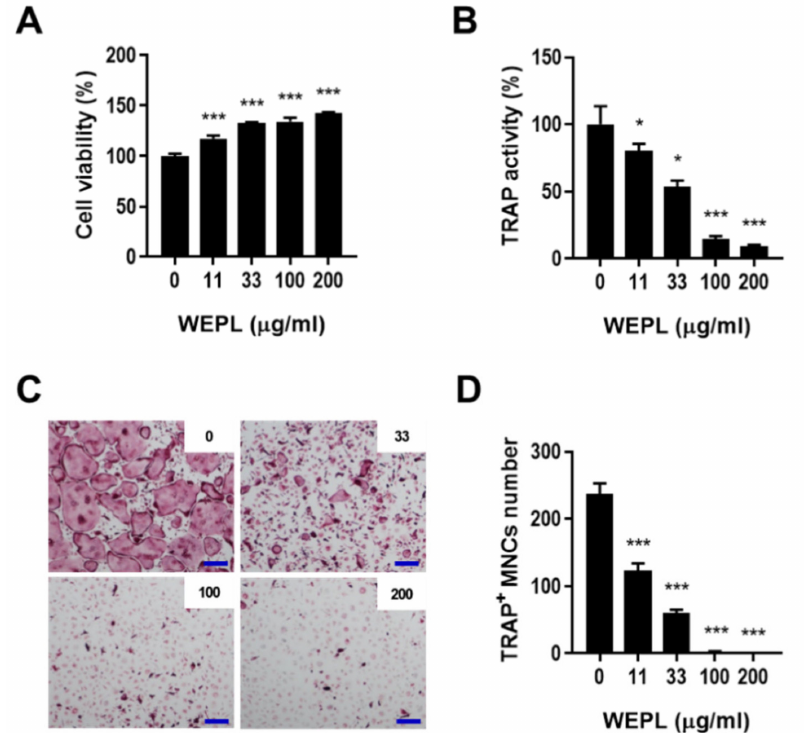
Figure 2. Effect of WEPL on the differentiation of osteoclast precursors. ( A ) BMMs were incubated with WEPL (0–200 µ g/mL) for one day, and cell viability was analyzed. ( B – D ) BMMs were cultured with or without WEPL in the presence of RANKL (50 ng/mL) and M-CSF (60 ng/mL). ( B ) Total TRAP activity. ( C ) Representative microscope images of TRAP-stained osteoclasts. Scale bar, 100 µ m. ( D ) The number of TRAP + MNCs. * p < 0.05, *** p < 0.001 vs. control non-treated with